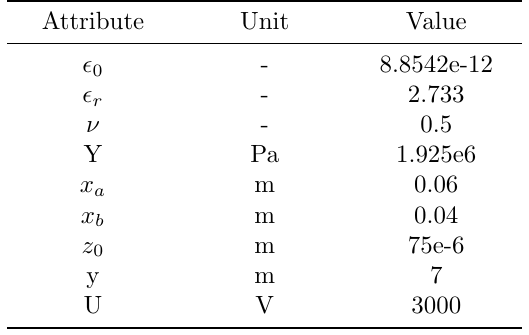
Table 5: The actuator parameters